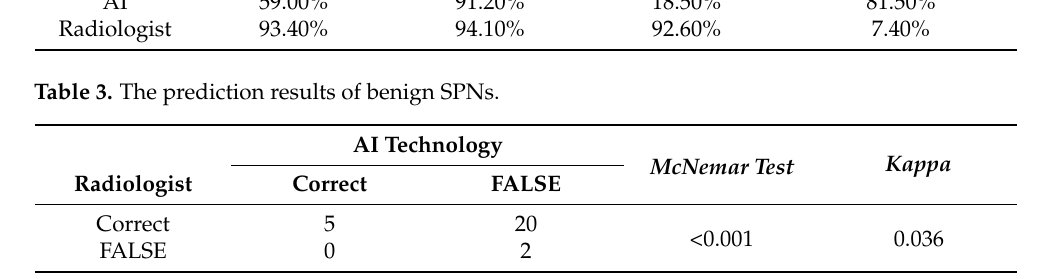
K < 0.4 means the two diagnosis methods fit